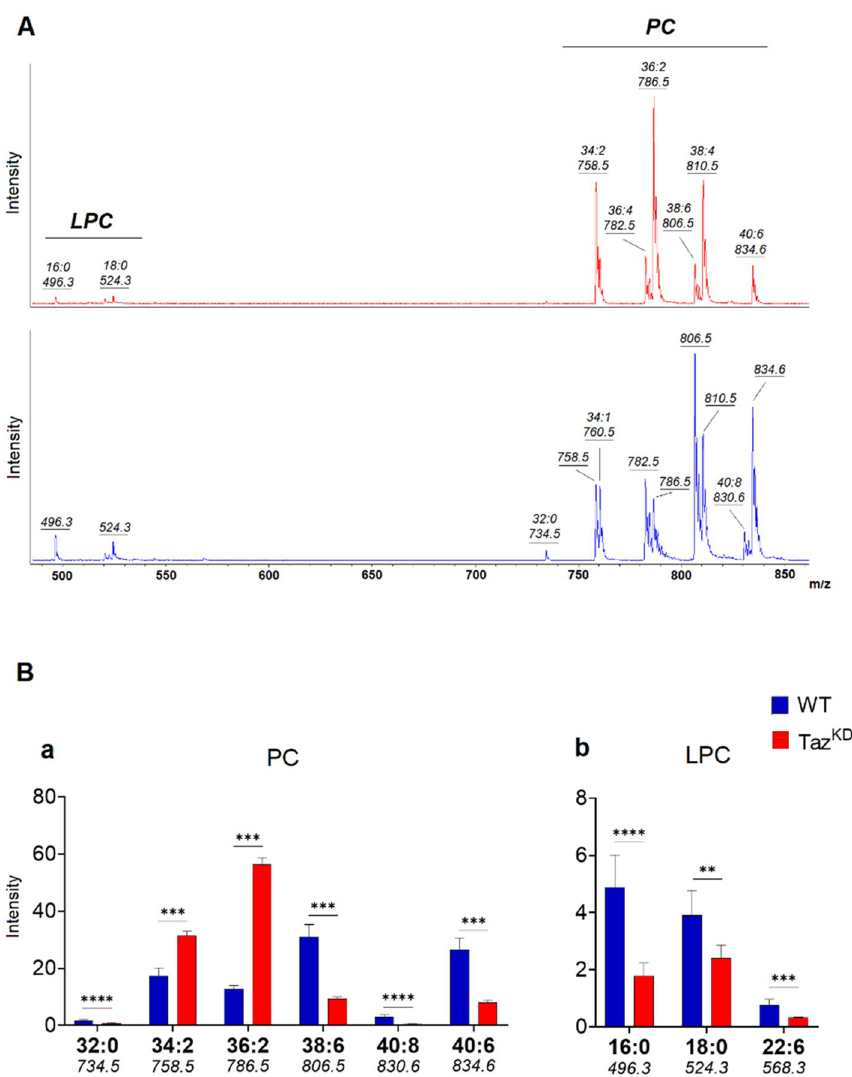
Figure 2. Positive ion mode MALDI-TOF/MS total lipid profiles of Taz KD (red) and WT (blue) cardiac mitochondria ( A ). Mitochondria were isolated from 4-month-old mice and representative lipid mass spectra are shown in ( A ). Lipid assignments for main signals are indicated. The histograms ( B ) show the significant differences in intensity between the lipid peaks in the two series of (+) mass spectra. Data are reported as the average value of intensity ± SD. A p-value < 0.05 was set as the threshold for significant differences between the series of mass spectra (*p < 0.05; **p < 0.01; ***p < 0.001, ****p < 0.0001). The numbers under each histogram indicate the detected MALDI m/z